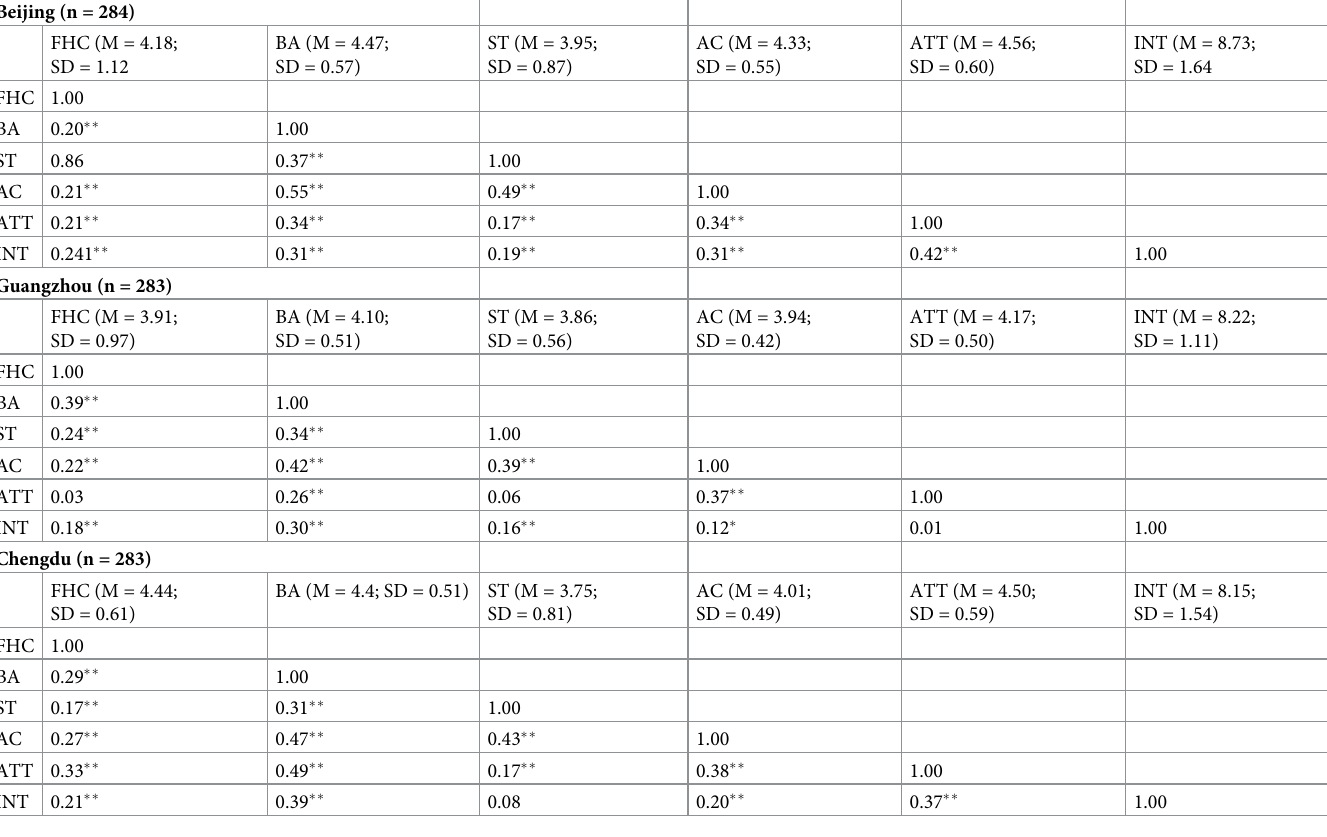
Table 6. Descriptive statistics and correlation analysis for the model